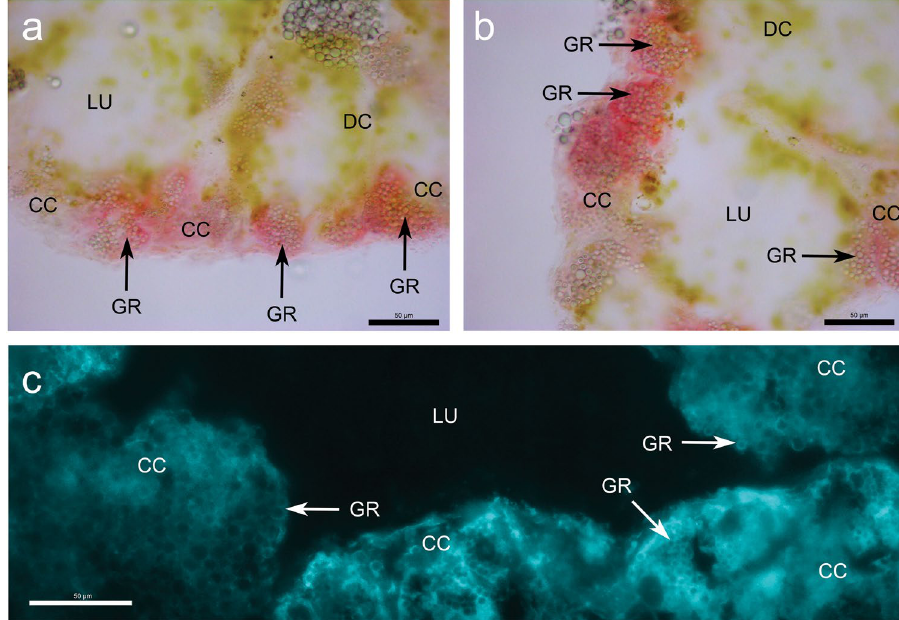
Figure 2. Zinc distribution in midgut gland sections of zinc-exposed Arion vulgaris with colour dithizone staining ( a , b ) and fluorescent toluenesulfonamidoquinoline (TSQ) staining ( c ). Midgut gland cross sections showing lumen (LU) surrounded by digestive cells (DC) and calcium cells (CC) containing calcium granules (GR). Zinc stained by dithizone (red colour) ( a , b ) is exclusively allocated in calcium cells. Fluorescent staining by TSQ localize zinc (bright blue colour) ( c ) mainly in cytoplasm of calcium cells and on the outer edge of calcium granules ( c - GR). The bar corresponds to a size of 50 µ